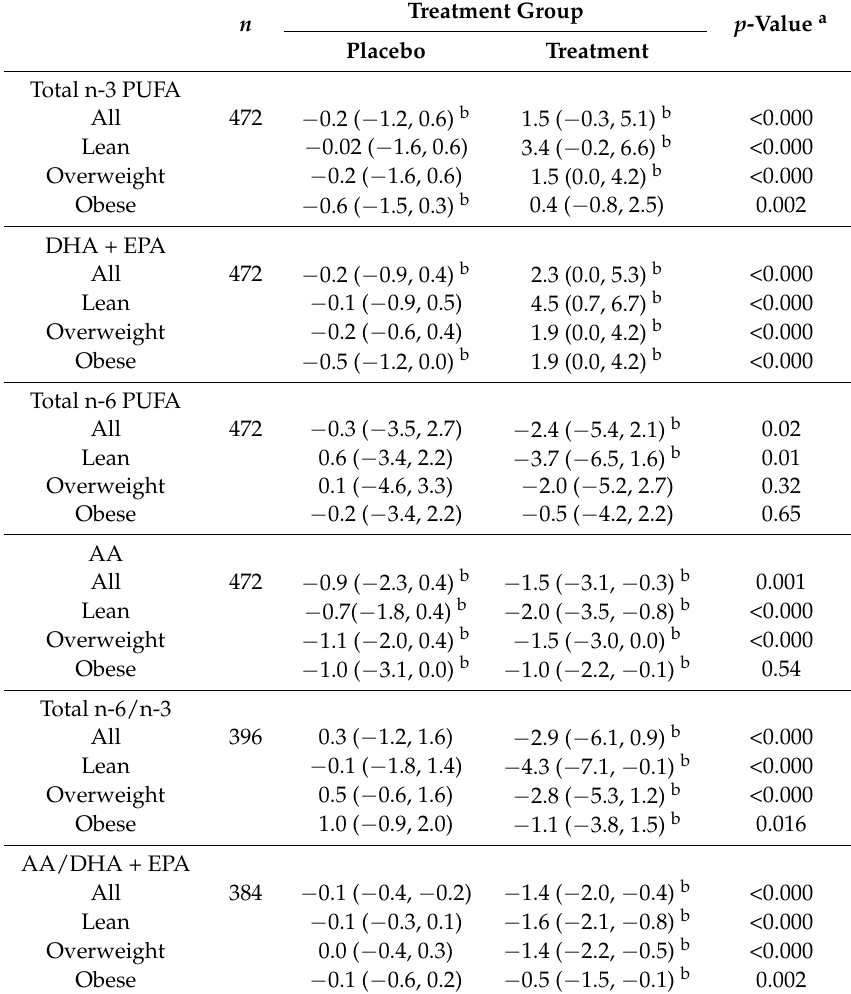
Table 4. Absolute change in PUFA concentrations following n-3 supplementation by treatment category, stratified by